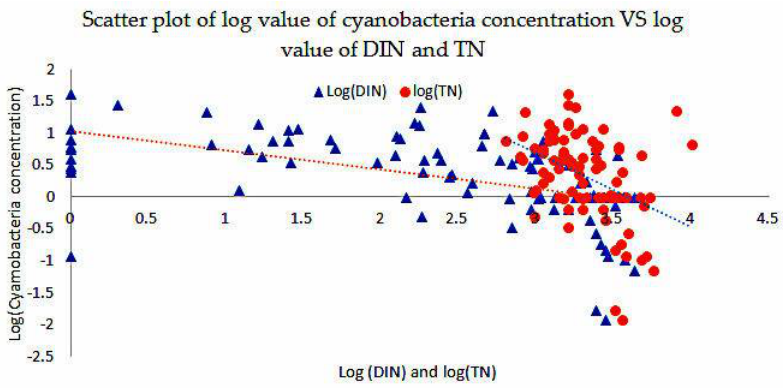
Figure 4. Comparison of the relation of dissolved inorganic nitrogen (DIN) with cyanobacteria biomass (triangle blue) and TN with cyanobacteria biomass (dot red).